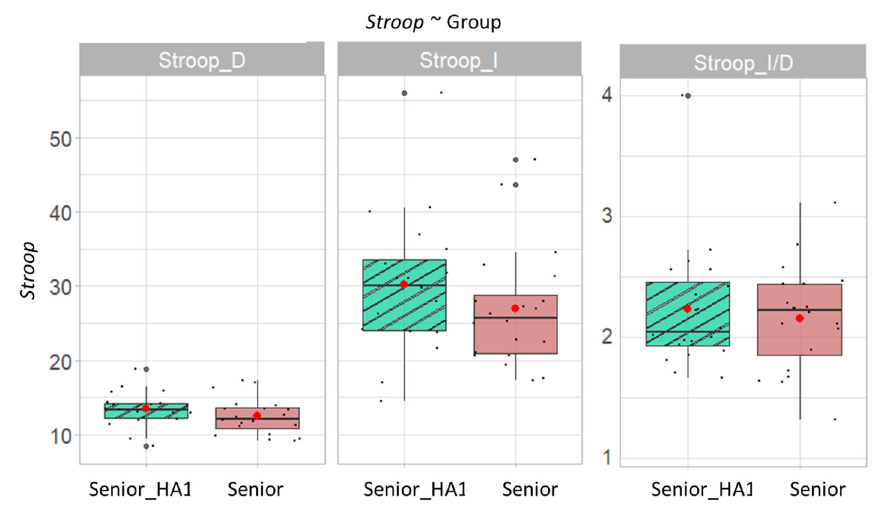
Figure 3. Stroop test scores as a function of group. Senior_HA1 represents the group Senior_HA when participants were wearing their hearing aids. Senior represents participants in the group